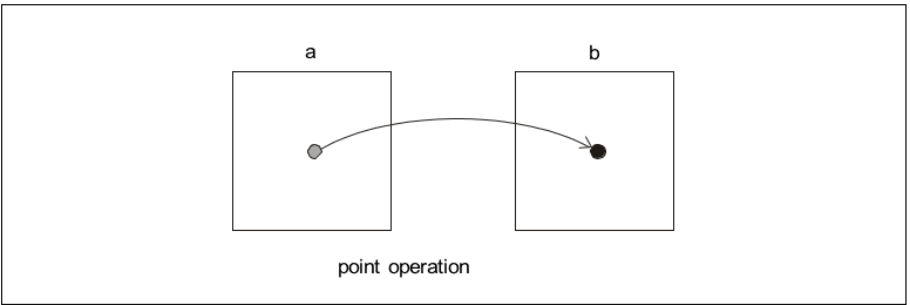
Figure 2. Diagram of general principle of the point operator (function)—the output of which is an unambiguous assignment of the value of a pixel in the output image. It is related to the value of a pixel in the input image.